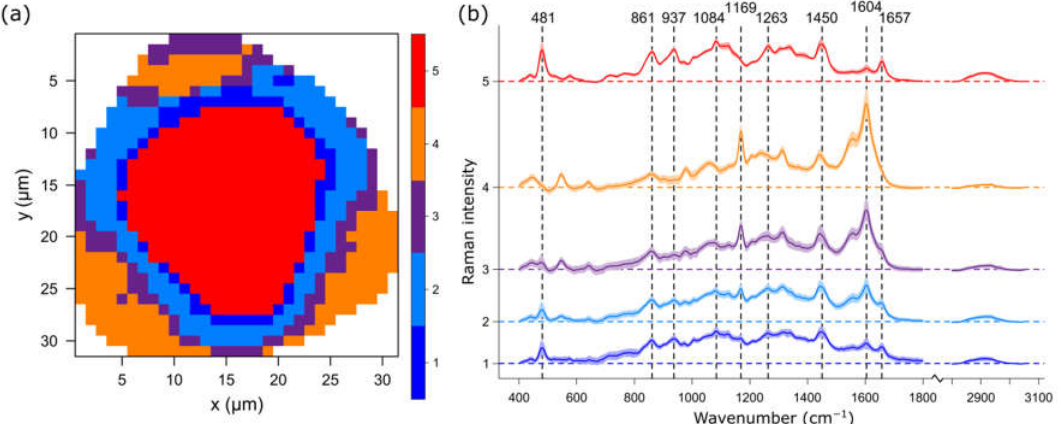
Figure 2. Representative cluster analysis of a Betula ermanii pollen grain. ( a ) HCA cluster image and ( b ) cluster spectra with the same color coding. HCA clustering was performed on, in total, 40 grains from seven different birch species. Five clusters described the pollen grain in detail, while clusters 1–4 represent four layers surrounding the inner core (cluster 5). The mean spectrum of cluster 4 reveals a high content of sporopollenin in the outside layer, which decreases in layers closer to the inner core (cluster 1–3). The mean spectra of cluster 5 are dominated by carbohydrate bands.